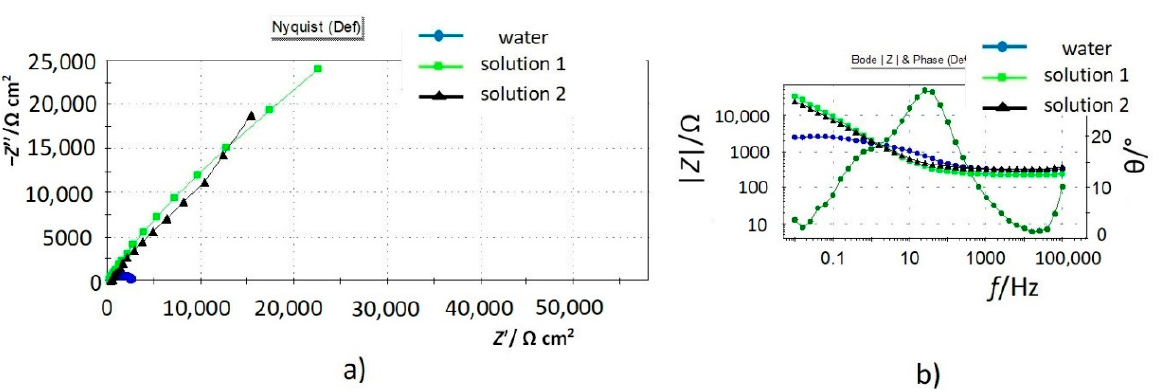
Figure 4. The comparative view of: ( a ) Nyquist’s EIS diagrams and ( b ) Bode plots obtained for HTCS-130 tool steel in water, solution 1, and solution 2.